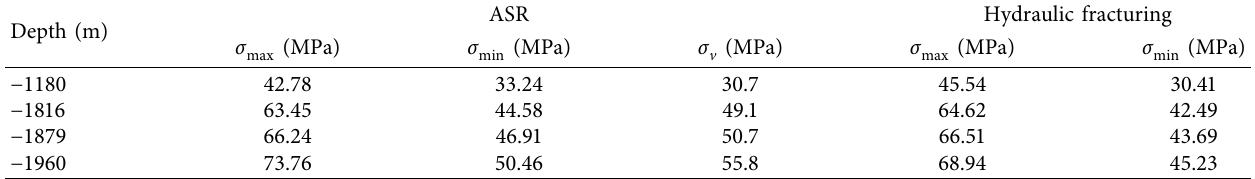
Table 3: In situ stress measurement results by ASR method and hydraulic fracturing